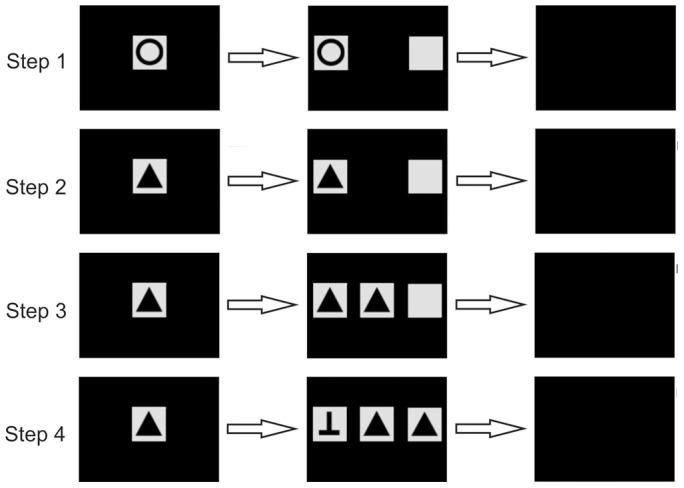
Examples of the sequences of PowerPoint slides used in the different steps of experiment 1b.For every step (1–4) of the experiment, possible slides presenting the stimuli and their duration per trial are given. In steps 1–3, a blank square instead of a distracting stimulus is used. The last slide denotes the ITI.